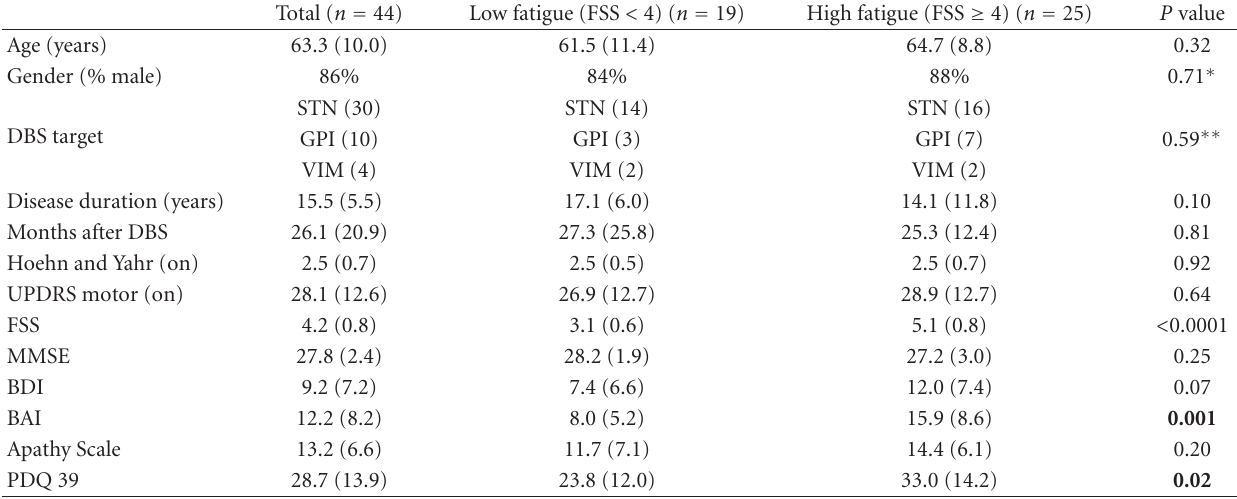
Table 1: Comparison of clinical characteristics in high and low fatigue patients. Data reported as mean (standard deviation).